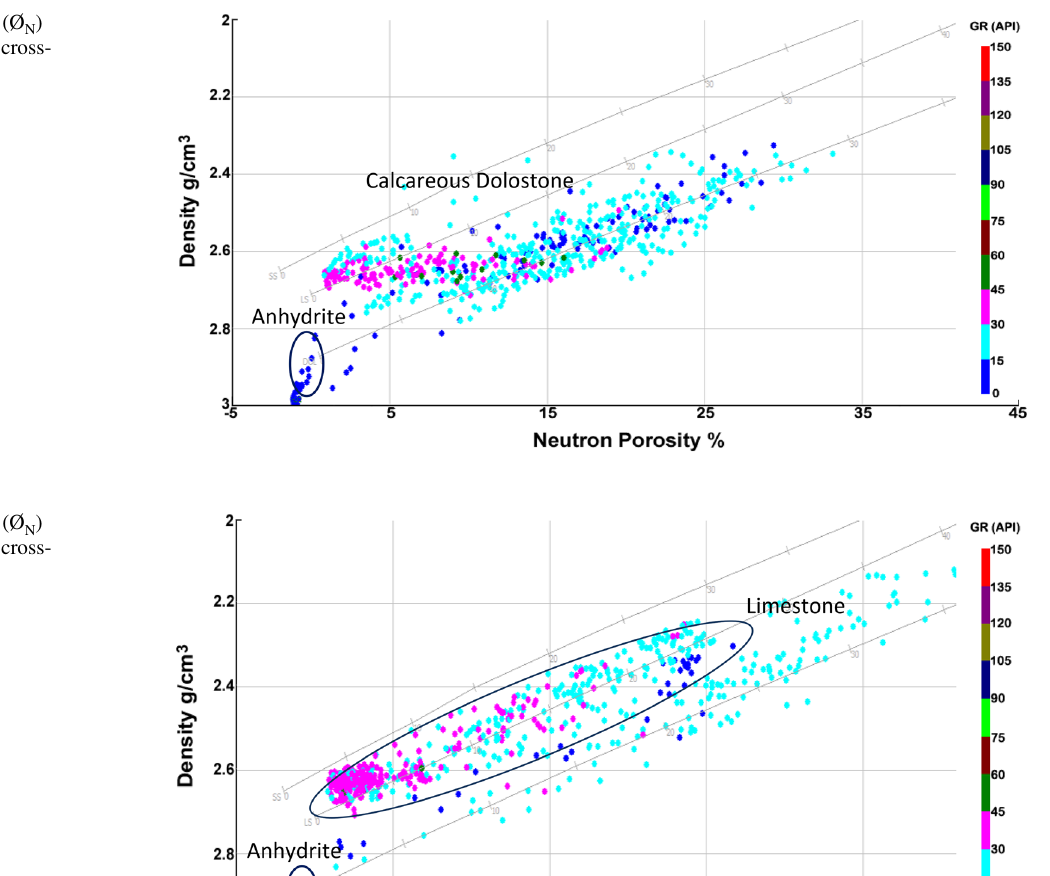
Fig. 5 Neutron porosity (Ø versus bulk density ( ρ b ) cross- plot of A13 well